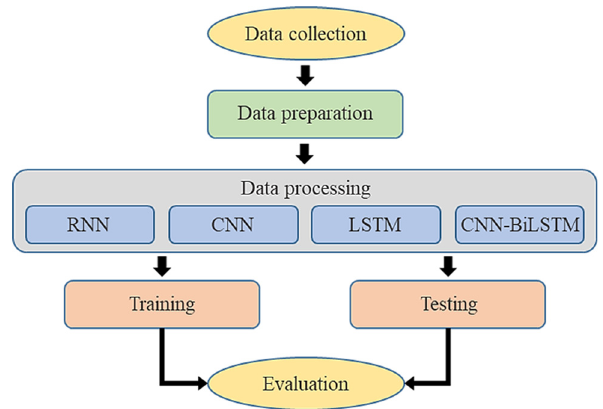
Figure 3: The experiment fl ow.